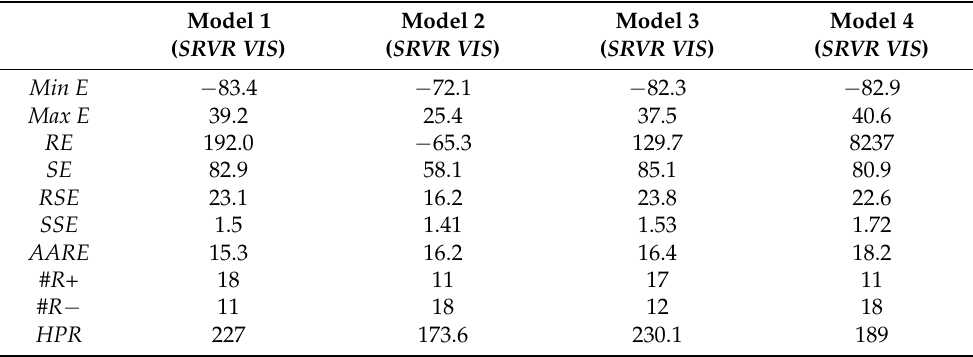
Table 11. Statistical analysis of the four SRVR viscosity